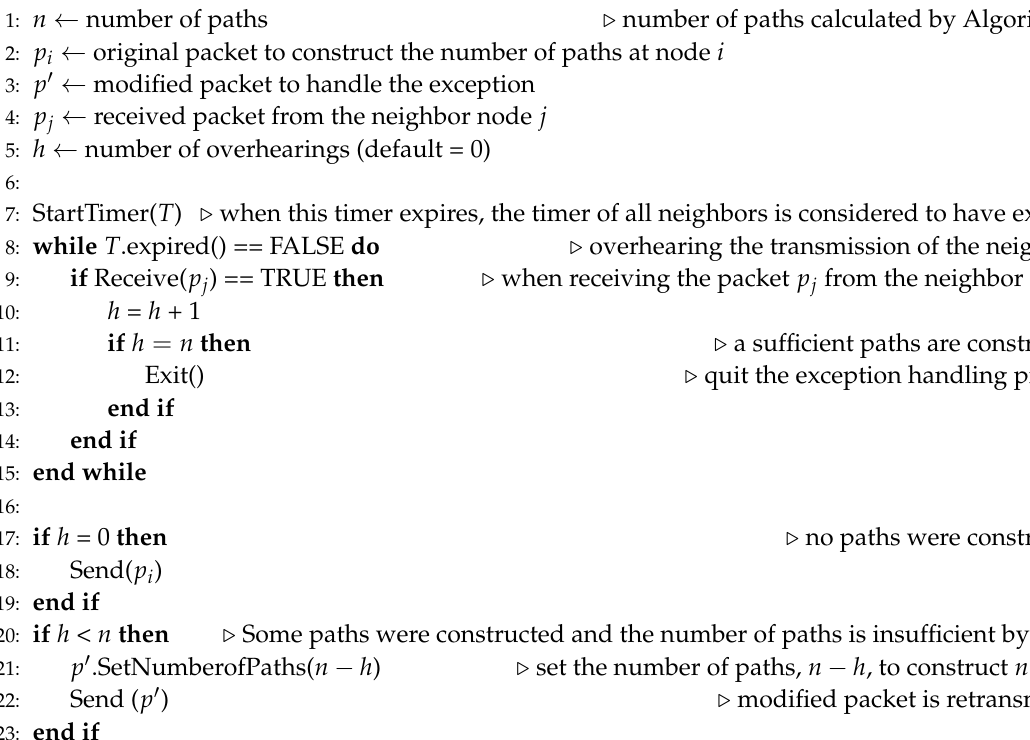
Algorithm 3 Pseudocode for an exceptional case handling process at an intermediate node i